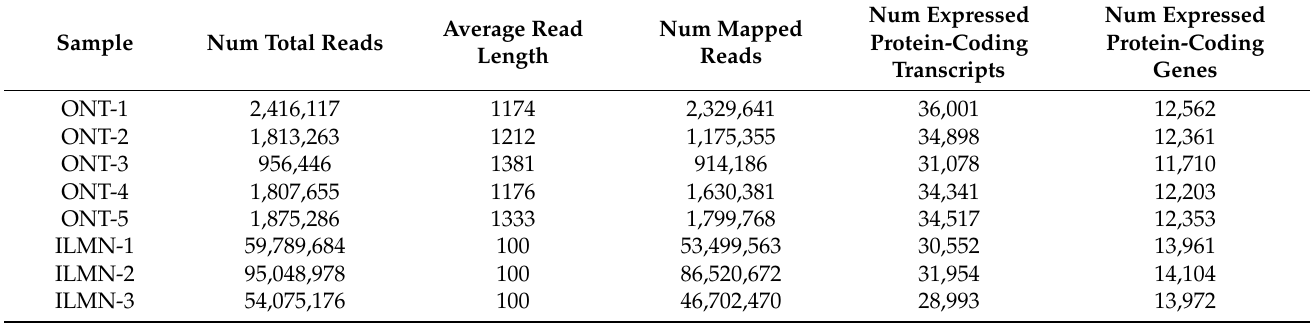
Table 1. Information about mapped reads and numbers of detected protein-coding transcripts and genes for each sample.